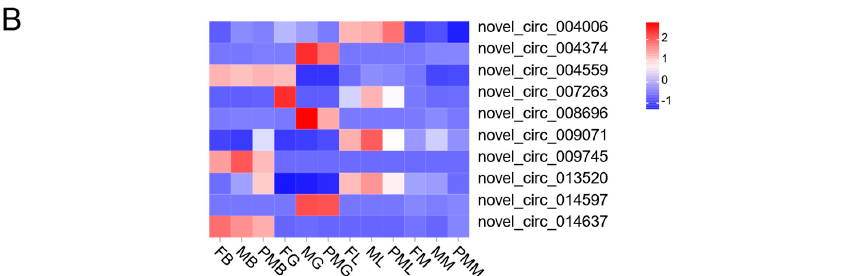
Figure 5. Functional circRNA–miRNA–mRNA regulatory module and the different expression of circRNAs in males, females, and pseudo males. ( A ) The circRNAs, miRNAs, and mRNAs are on the left, middle, and right, respectively. ( B ) Heatmap of the different expression of circRNAs in gonads, brains, muscles, and livers of males, females, and pseudo males.